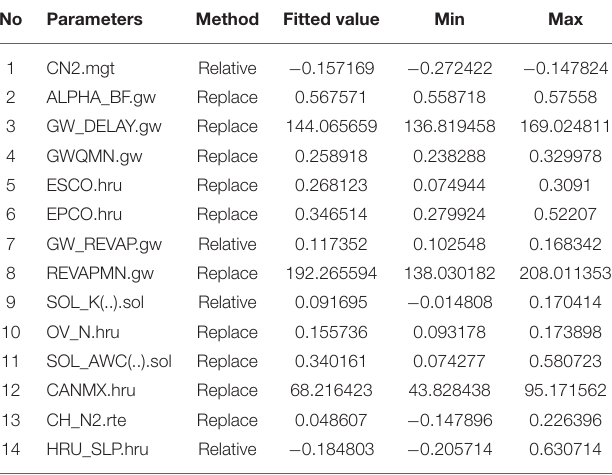
( Table 5 ). Simulated streamflow was compared with observed streamflow using the statistical metrics: Nash-Sutcliffe Efficiency (NSE), correlation coefficient ( R 2 ), percent bias (p-bias), and Root Mean Squared Error (RMSE)